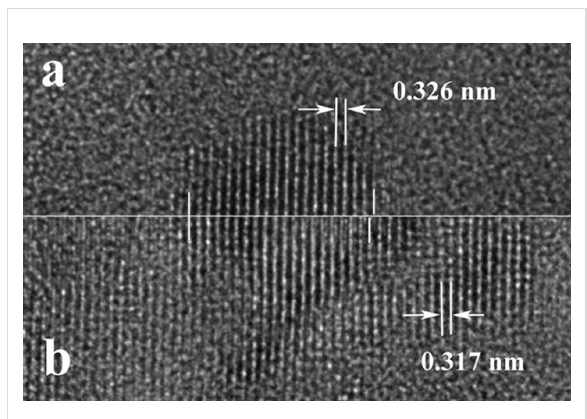
Figure 10: High-resolution TEM images comparing details of the initial crystallized particle (a) and the same area of the particle after the crystal growth process (b). The lattice fringe spacing in panel (b) is smaller than that in panel